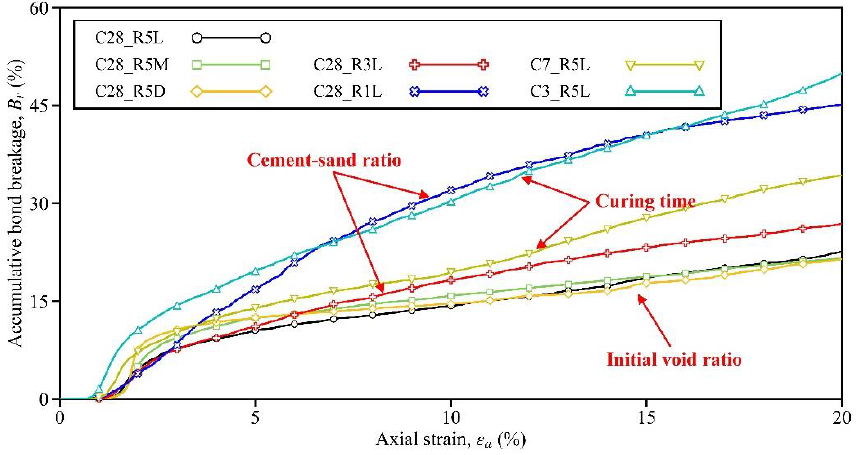
Figure 9. The rate of accumulative bond breakage for the seven samples.